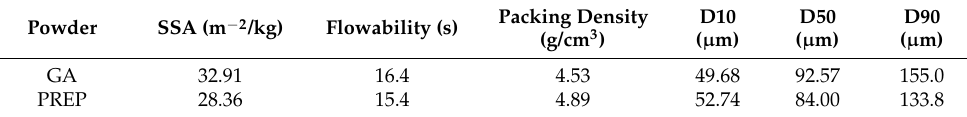
Figure 2. Volume fraction distribution of powder particles. Table 3. Powder properties of two types of GH4099.